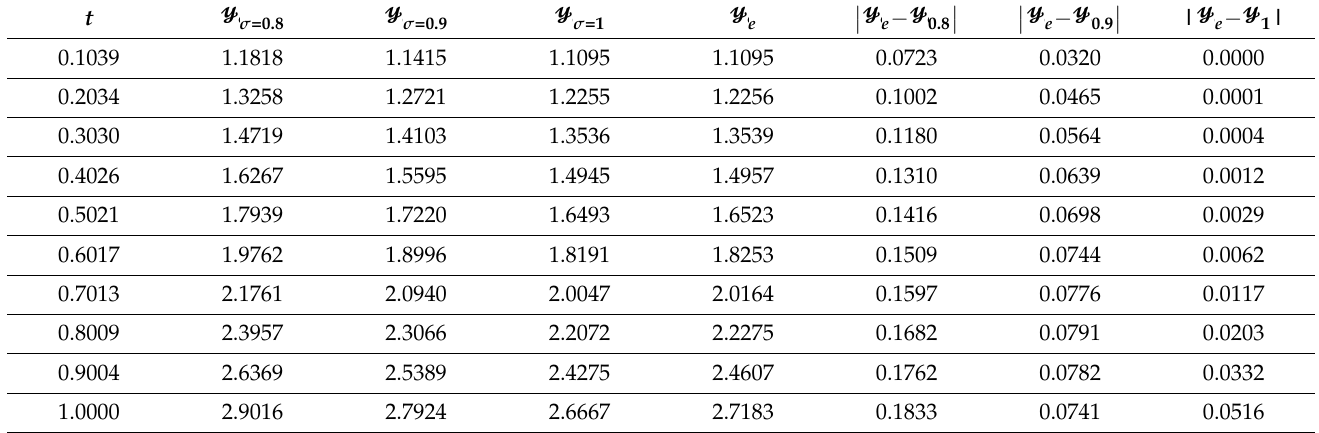
Table 1. Values of the approximate and exact solutions of Equation (19) at di ff erent values of 𝓉 . 𝒕 𝔂 𝝈(cid:2880)𝟎.𝟖 e −